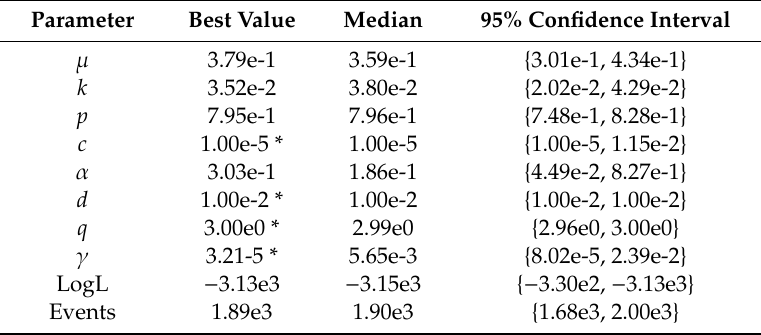
Table 9. Parameter estimates for Central Africa. Estimation results for the eight parameters of the ETAS model, the log likelihood and the number of events for the Central Africa conflict catalog. Estimates marked with a * are at, or very close to, their constraint values. The best estimate, that is, the estimate of the run with the highest log likelihood, is given for each parameter. Furthermore, the median and the 95% confidence intervals are